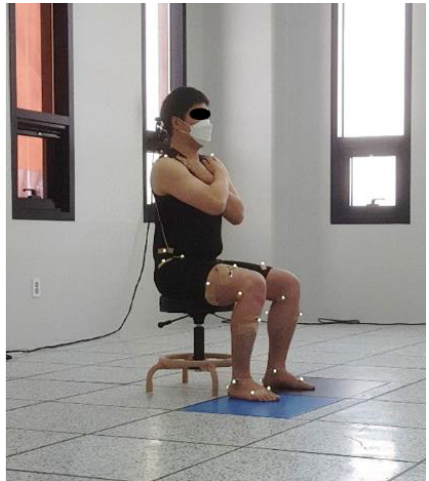
Figure 1. Experimental preparation posture.